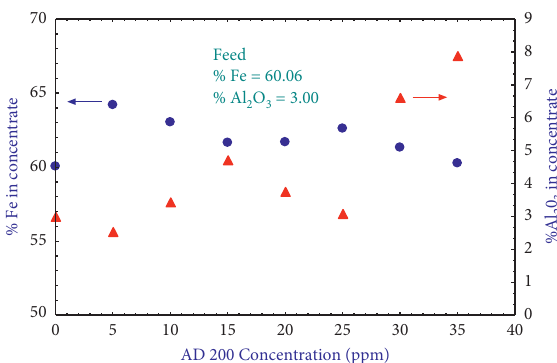
Figure 8: Amount of Fe and Al 2 O 3 in the concentrate from 25 wt. % slurry of slime at different doses of AD 200 at pH